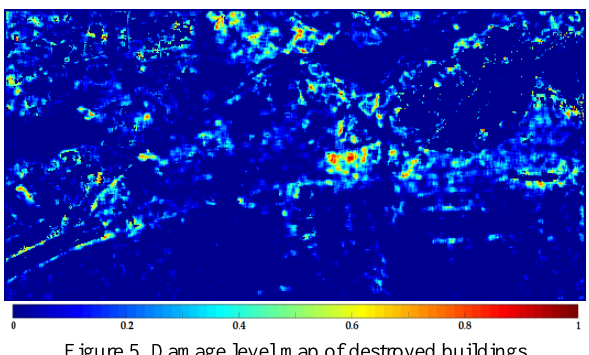
Figure 5. Damage level map of destroyed